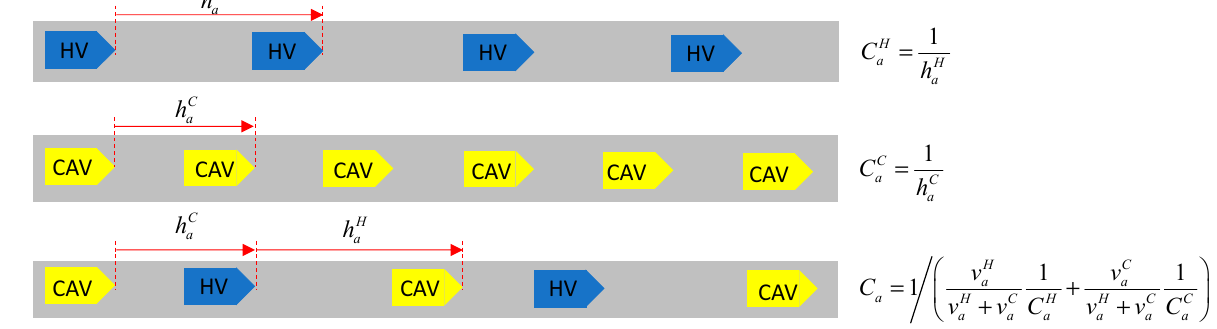
Figure 1. Example of the headway in mixed traffic flows.